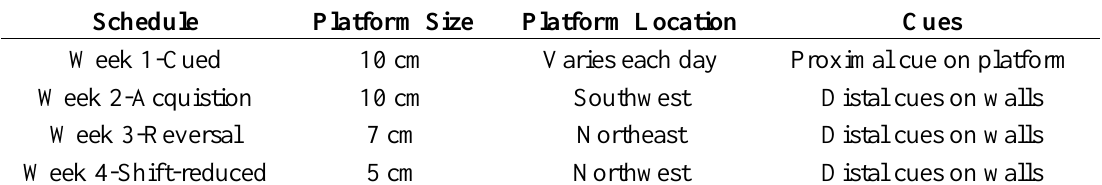
Table 1. Platform positions and cues for the Morris water